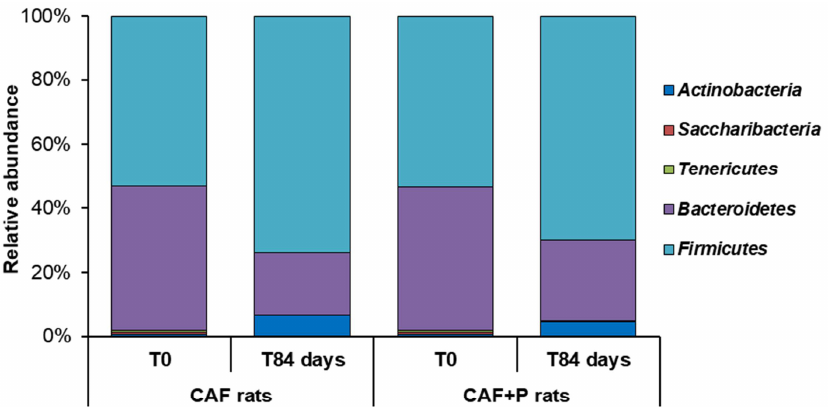
Figure 6. Modulation of microbiota community by Lactiplantibacillus plantarum IMC 510. Relative abundance of bacterial phyla differing between the groups, fed on CAF diet supplemented or not with probiotics. CAF: cafeteria; P: probiotic supplementation.